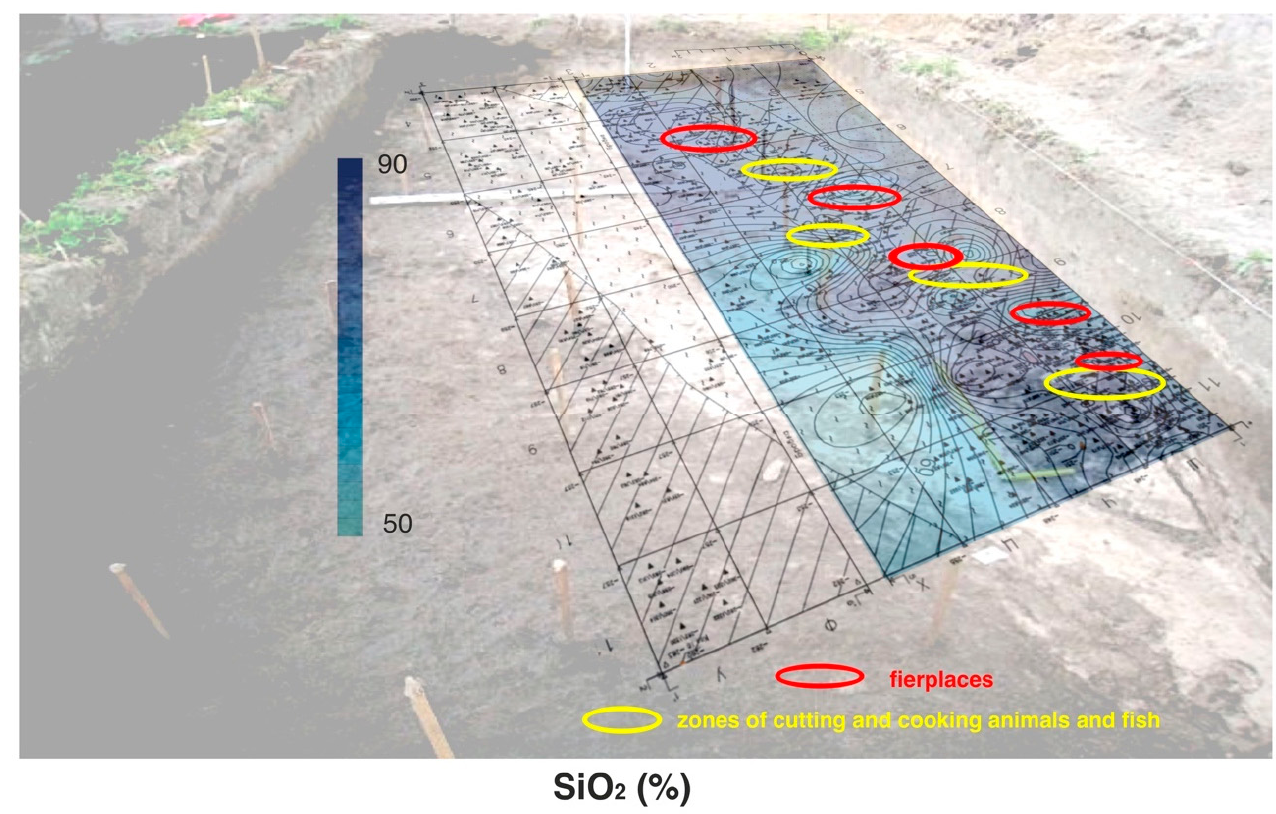
Figure 11. Features of relief on the base of SiO 2 distribution at the site surface and location of different types of functional zones based on geochemical reconstructions at the Podolye site [38], designed by M.Kulkova.